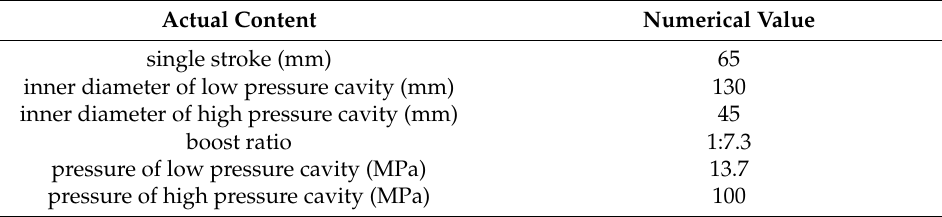
Table 3. Actual design parameters of the pressurized cylinder.